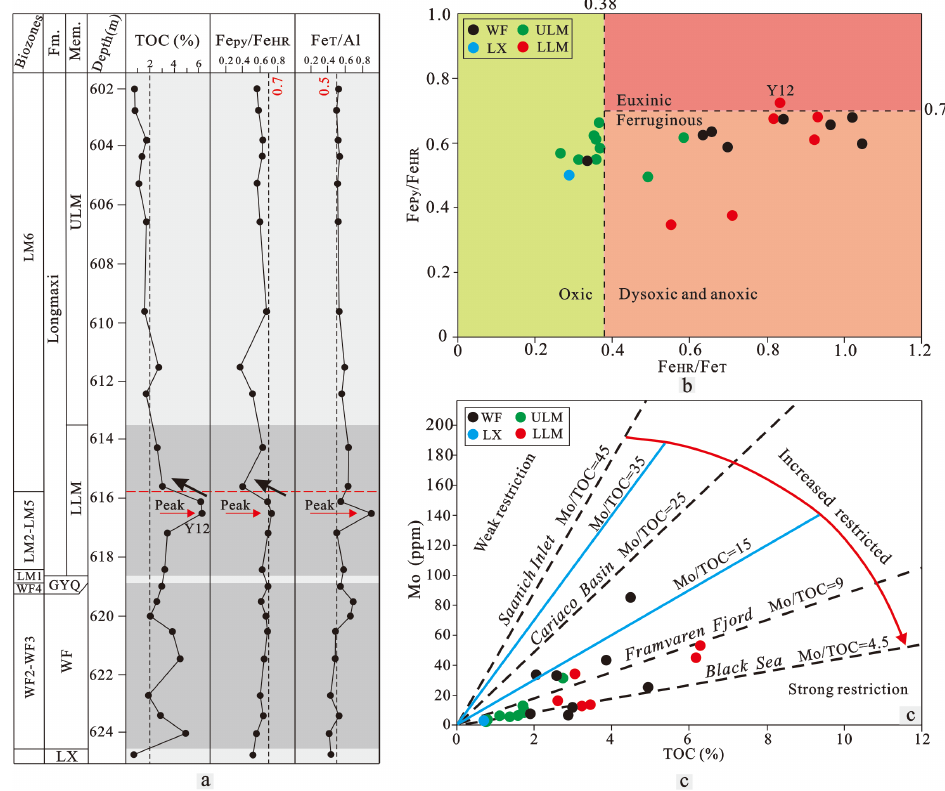
Figure 11. ( a ) Vertical variation in palaeoredox condition proxies Fe py /Fe HR and Fe T /Al in the Wufeng – Longmaxi Formation in well YD1 showing mainly ferruginous conditions except for one sample in the lower LLM that was deposited under euxinic conditions. ( b ) Crossplots of redox proxies Fe py /Fe HR vs. Fe HR /Fe T showing that LX and ULM were mainly deposited under oxic conditions and WF and LLM were primarily deposited under ferruginous conditions. ( c ) Crossplots of TOC vs. Mo showing that the Mo/TOC values of most samples are lower than 15 × 10 −4 [15], indicating a strong degree of restriction.